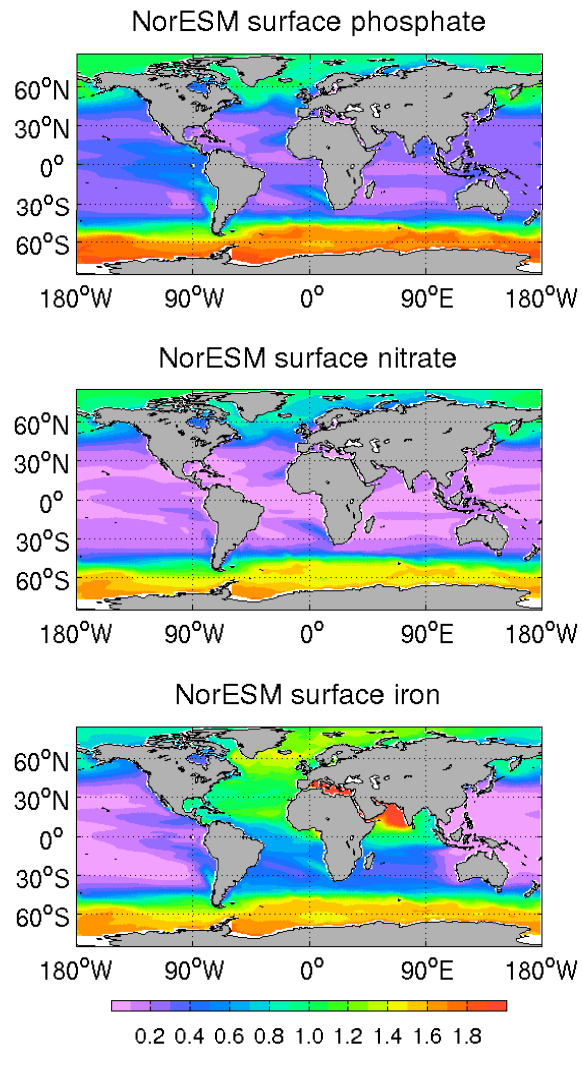
Fig. 9. Annual mean surface phosphate (top), nitrate (middle), and dissolved iron (bottom) concentration for the 1980–1999 periods shown in the same equivalent [µmolPL − 1 ] unit.